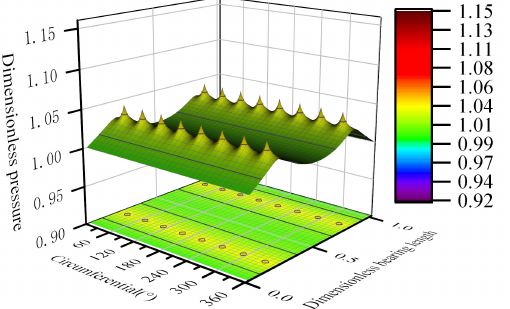
Figure 5. Dimensionless pressure distribution of ideal